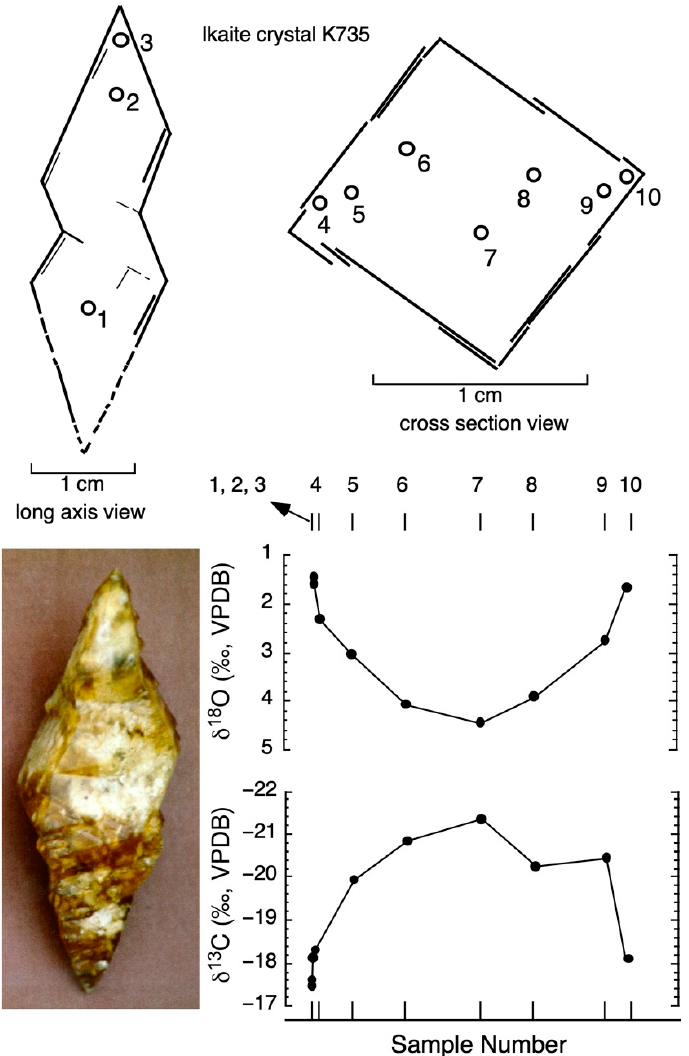
Figure 7. Carbon and oxygen isotope measurement traverse across ikaite crystal. Changes in δ 13 C ikaite reflect changes in δ 13 C DIC due to uptake of 12 C DIC by methanogens during hydrogenotrophic methanogenesis. The changes in δ 18 O ikaite are possible due to kinetic isotope effects during the formation or the partial recrystallization of ikaite to calcite. Table 2. Carbon and oxygen profiles across ikaite crystal (sample K735) and glendonites.